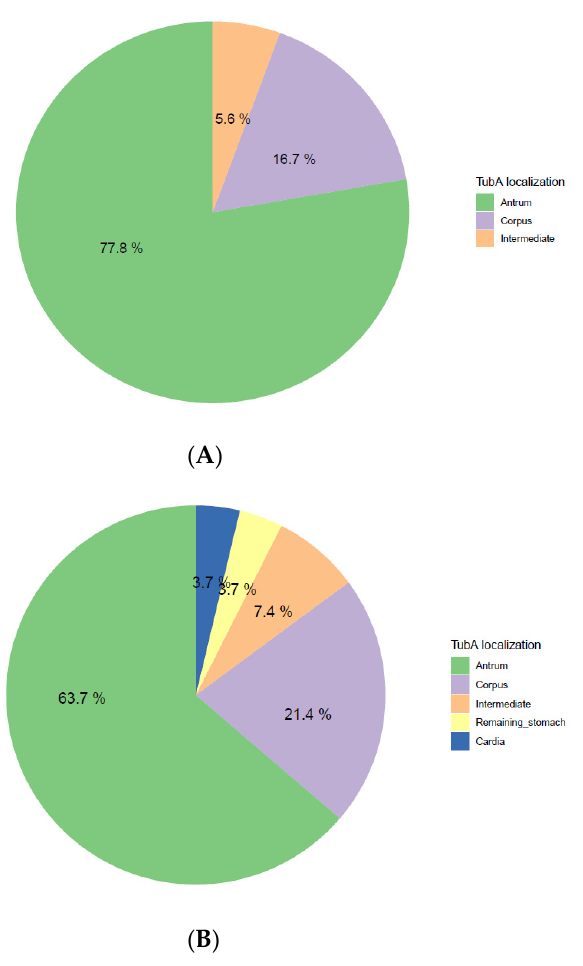
Figure 6. Distribution of intestinal-type adenoma localization within ( A ) Corpus dominant H. pylori gastritis and ( B ) H. pylori gastritis ( B ). TubA: intestinal-type adenoma. In lymphocytic gastritis, all adenomas were TubAs, and one of them was associated with